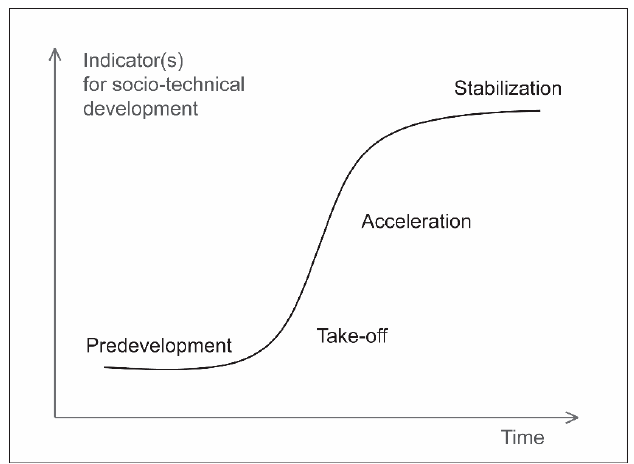
Figure 1 . The four transition phases of socio-technical transitions (based on [11]). Figure 1. The four transition phases of socio-technical transitions (based on